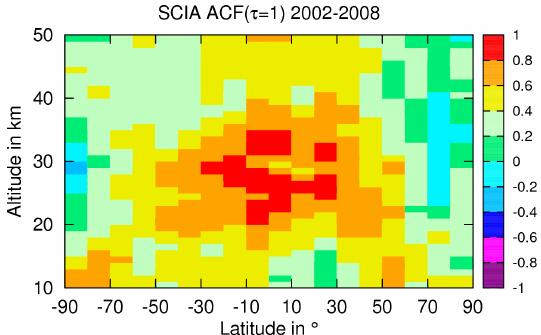
Fig. 7. Autocorrelation φ at lag τ =1 (one month) for SCIAMACHY ozone profiles from 2002 to 2008